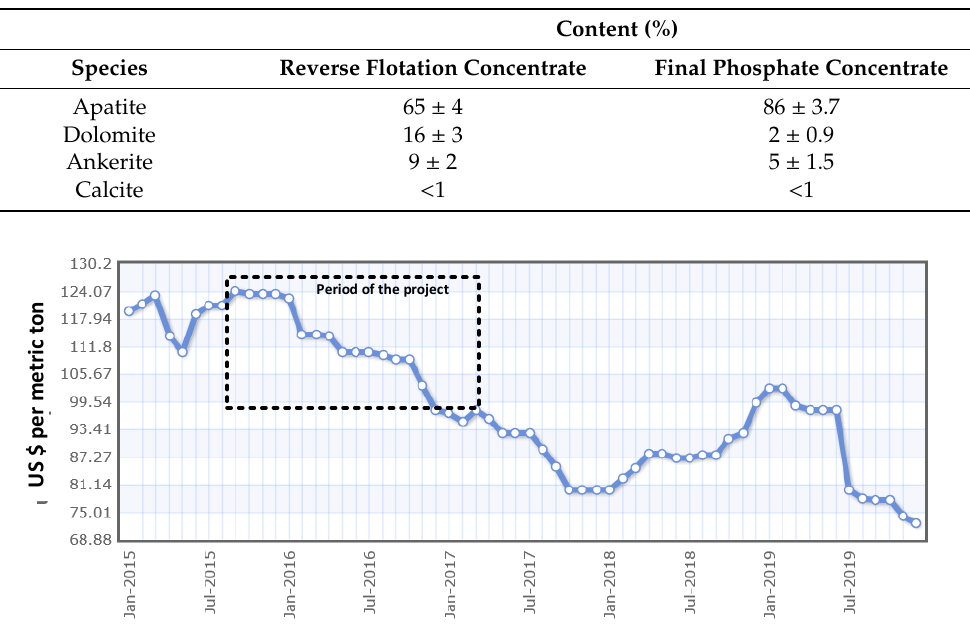
Table 9. Mineral contents of the final phosphate concentrate (average ± standard deviation of the results of 3 runs of the whole process).